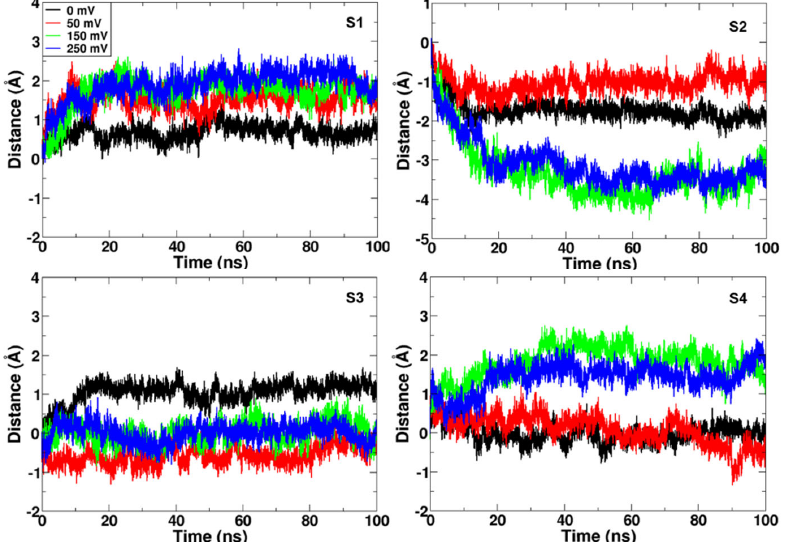
Figure 3. The moving distances of the four helices along the normal to the membrane bilayers ( z -axis) relative to the center of the four helices. Alpha carbon atoms of each helix were used to calculate the distance as a reference. The analyses for helices S1 to S4 are plotted separately and colored according to the four simulations; black, red, green, and blue lines for 0 mV, 50 mV, 150 mV and 250 mV, respectively. Significant downward displacement of the S2 and upward movement of the S4 helices are shown in the 150 mV and 250 mV simulations relative to the 0 mV and 50 mV simulations.